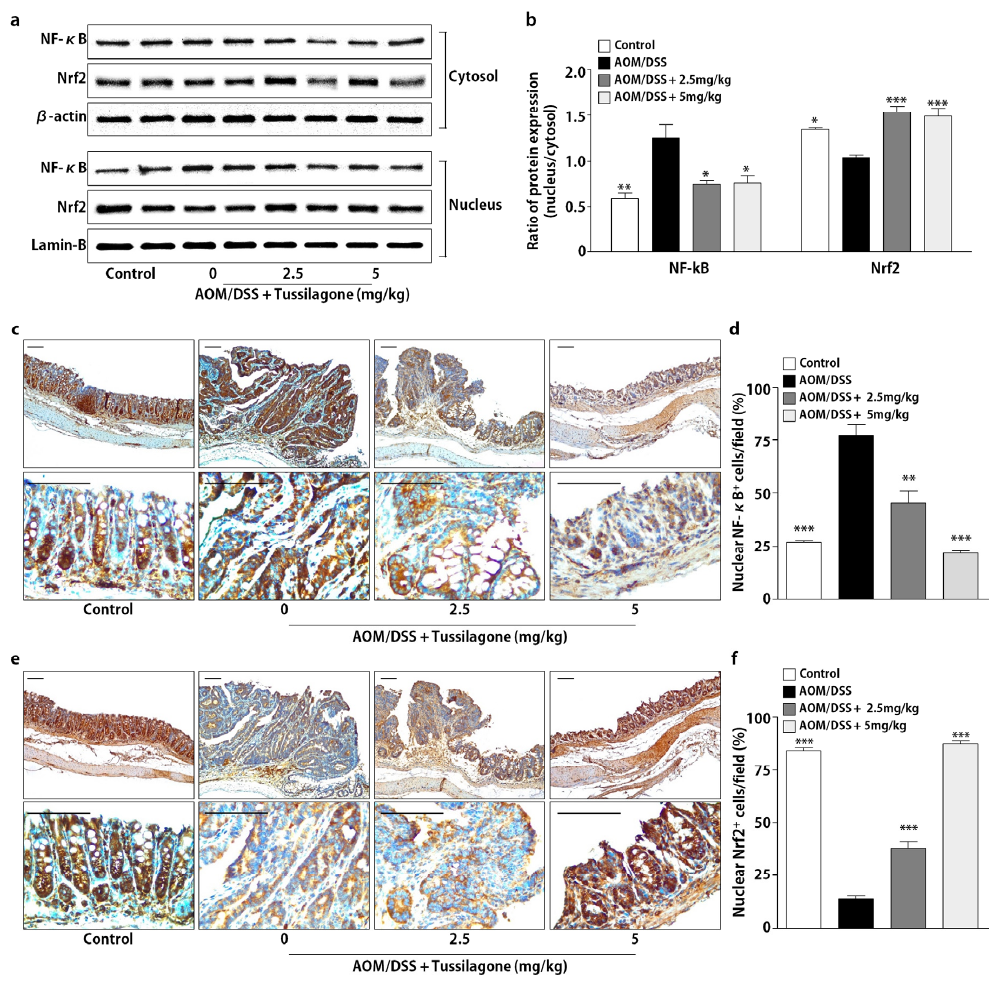
Figure 3. E ff ect of tussilagone on NF- κ B and Nrf2 activities in the colon tissues. ( a ) The protein samples in cytosol or nuclear fraction from the colon tissues were separated by SDS-PAGE. NF- κ B and Nrf2 were detected by Western blot and visualized by chemiluminescence. Photos are representative images. ( b ) The quantitative data were normalized by internal control ( β -actin for cytosol; lamin-B for nuclear fraction) and further expressed as folds, presented as the comparison with the amount relative to the AOM / DSS-treated mice. ( c ) The immunohistochemical analysis of nuclear NF- κ B expression in the colon tissues (upper, × 100 magnification; lower, × 400 magnification; bar = 100 µ m). ( d ) The percentage of nuclear NF- κ B positive cells in colon tissues was calculated as described in Methods. ( e ) The immunohistochemical analysis of nuclear Nrf2 expression in the colon tissues (upper, × 100 magnification; lower, × 400 magnification; bar = 100 µ m). ( f ) The percentage of the nuclear Nrf2 positive cells in colon tissues was calculated as described in Methods. Results are expressed as the mean ± SEM. * P < 0.05, ** P < 0.01, *** P < 0.001, compared to the AOM / DSS-treated mice.